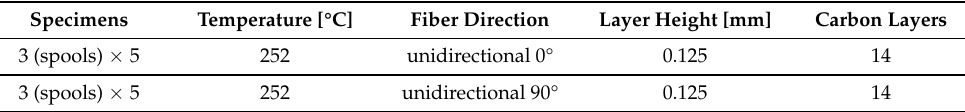
Table 1. 3D printing parameter settings for CF/PA6 bending test specimens, manufactured by CFF with the desktop 3D printer Mark